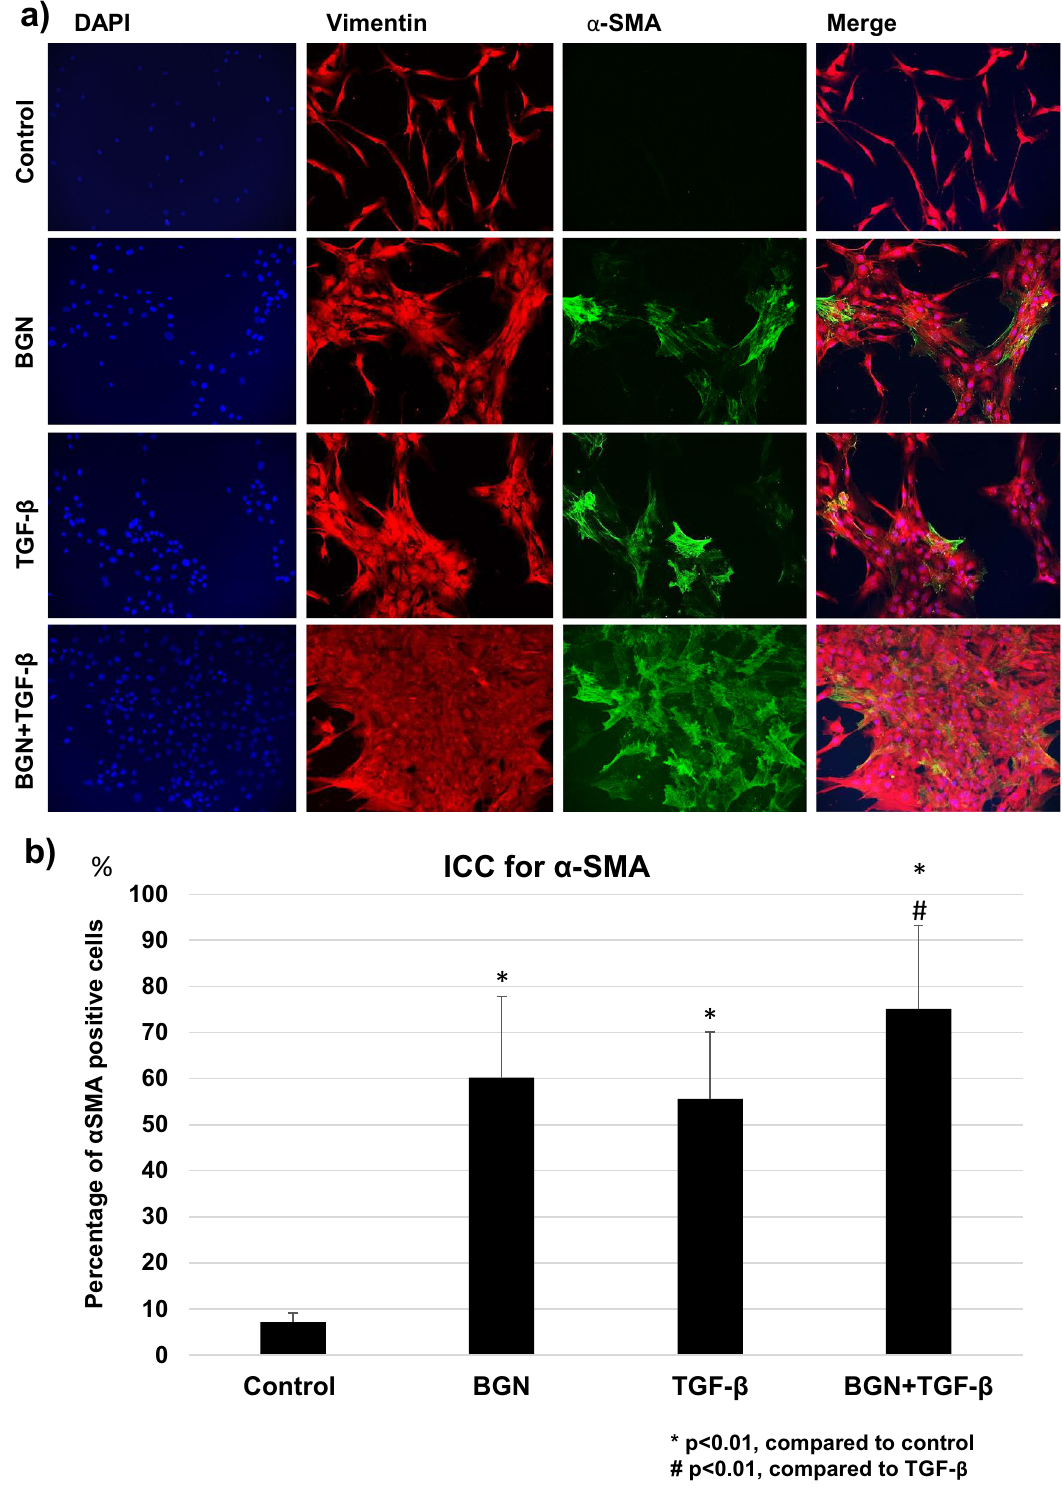
Figure 7. ( a ) Immunocytochemistry for vimentin and α-SMA in the cells from hypertrophied LF after treatment with TGF-β, BGN, and their combination; ( b ) average percentage of α-SMA-positive cells in each